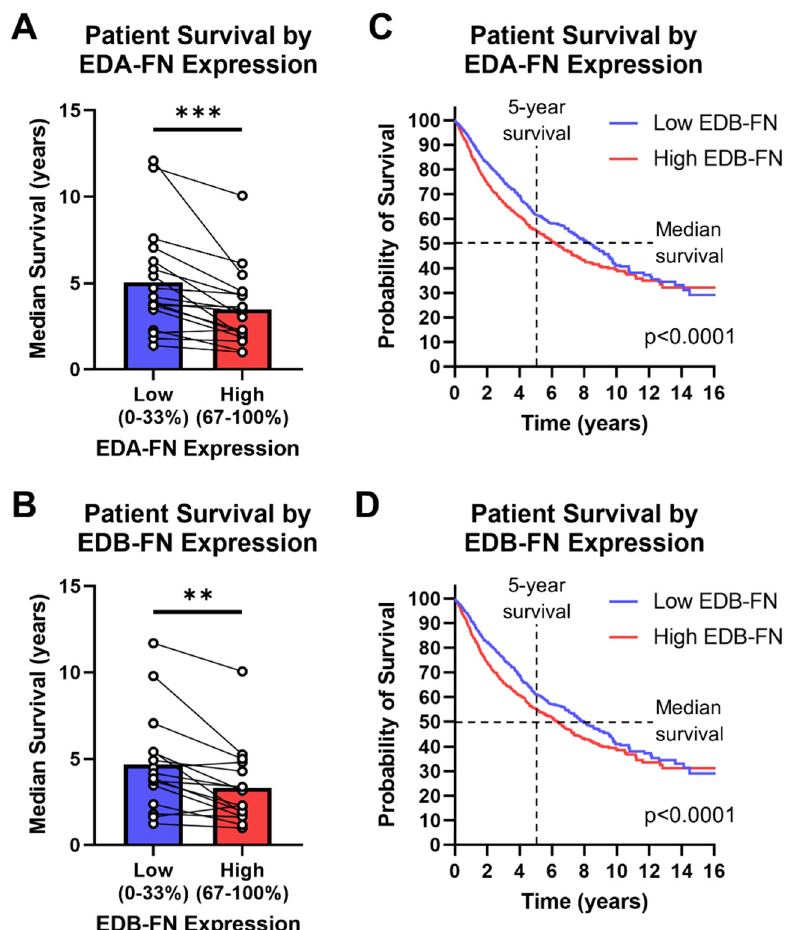
Figure 8. Oncofetal FN expression and patient prognosis. Median patient survival time based on high (top 33%) or low (bottom 33%) ( A ) EDA-FN ( n = 18) and ( B ) EDB-FN ( n = 16) expression within each cancer type. Pan-cancer Kaplan–Meier survival curves comparing patients expressing low and high levels of ( C ) EDA-FN (low, n = 3055; high, n = 3055) and ( D ) EDB-FN (low, n = 3051; high, n = 3046). Low- and high-expression groups were determined within each cancer type before being combined into a single dataset. Significance: **, p < 0.01; ***, p < 0.001.